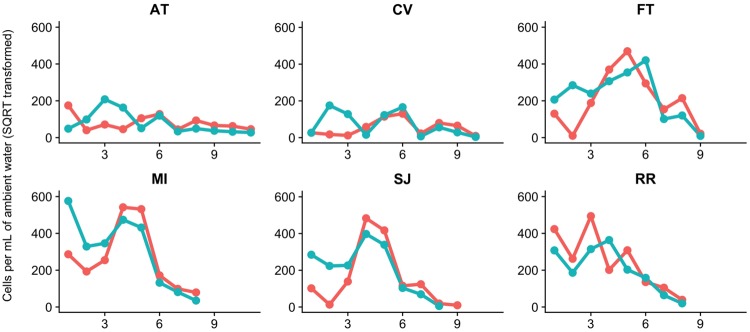
Temporal dynamic changes of Microcystis Genotype I (red) and VI abundance (teal) at the six sampling stations measured by qPCR (square root transformed) using subsurface ambient water samples.The x-axis indicates survey identification numbers (1: July 14th; 2: July 28th; 3: August 11th; 4: August 25th; 5: September 11th; 6: September 29th; 7: October 13th; 8: October 27th; 9: November 10th; 10: November 24th; 11: December 10th, 2014).